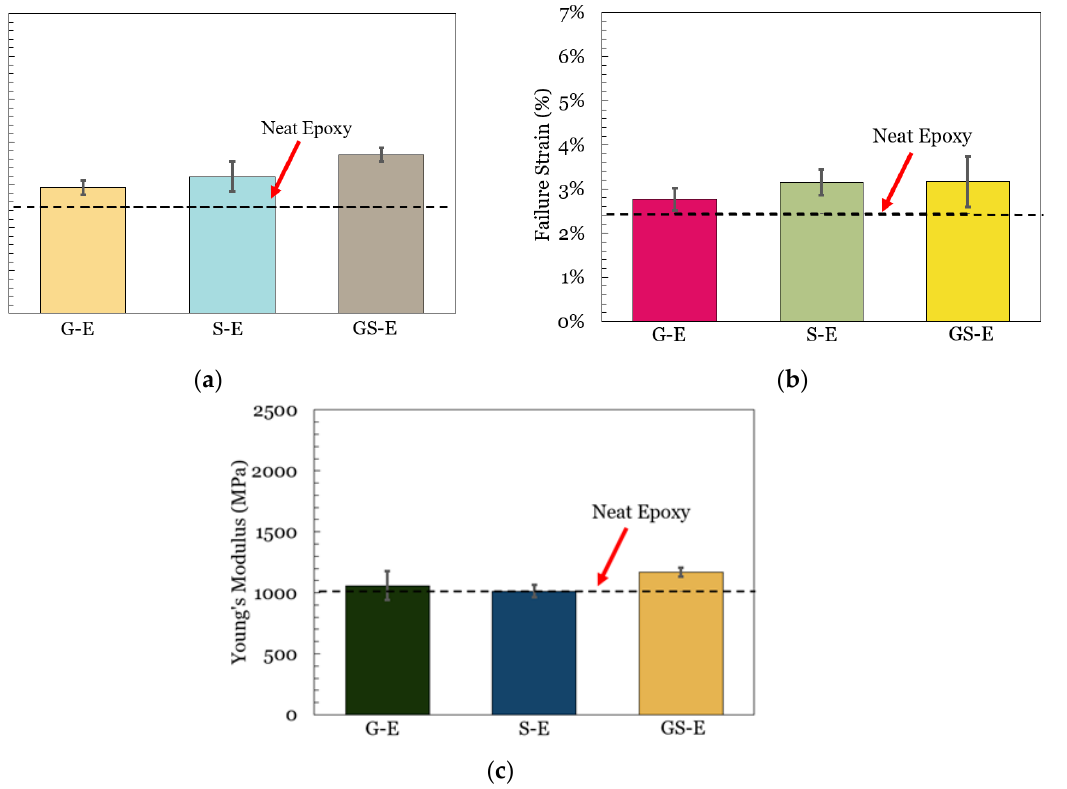
Figure 8. Tensile properties of each nanocomposite: ( a ) tensile strength, ( b ) failure strain, and ( c ) Young’s modulus. ( c ) Young’s